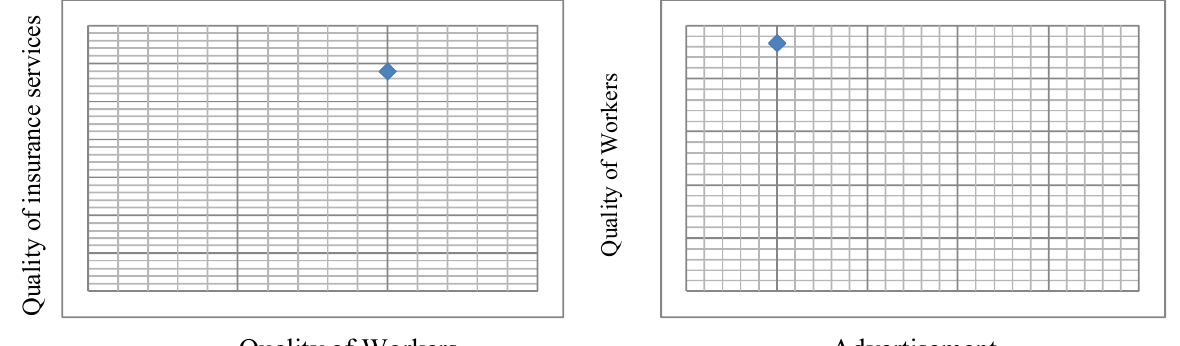
Fig. 2. The position of the firm based on selected